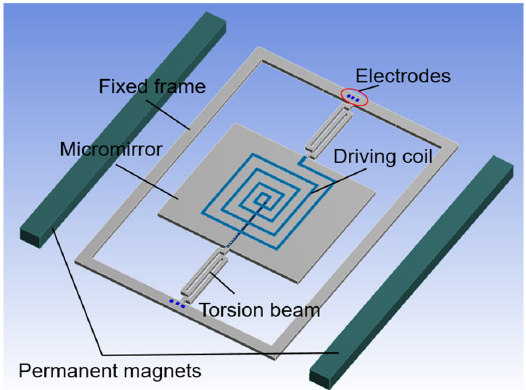
Figure 1. The schematic diagram of the electromagnetic